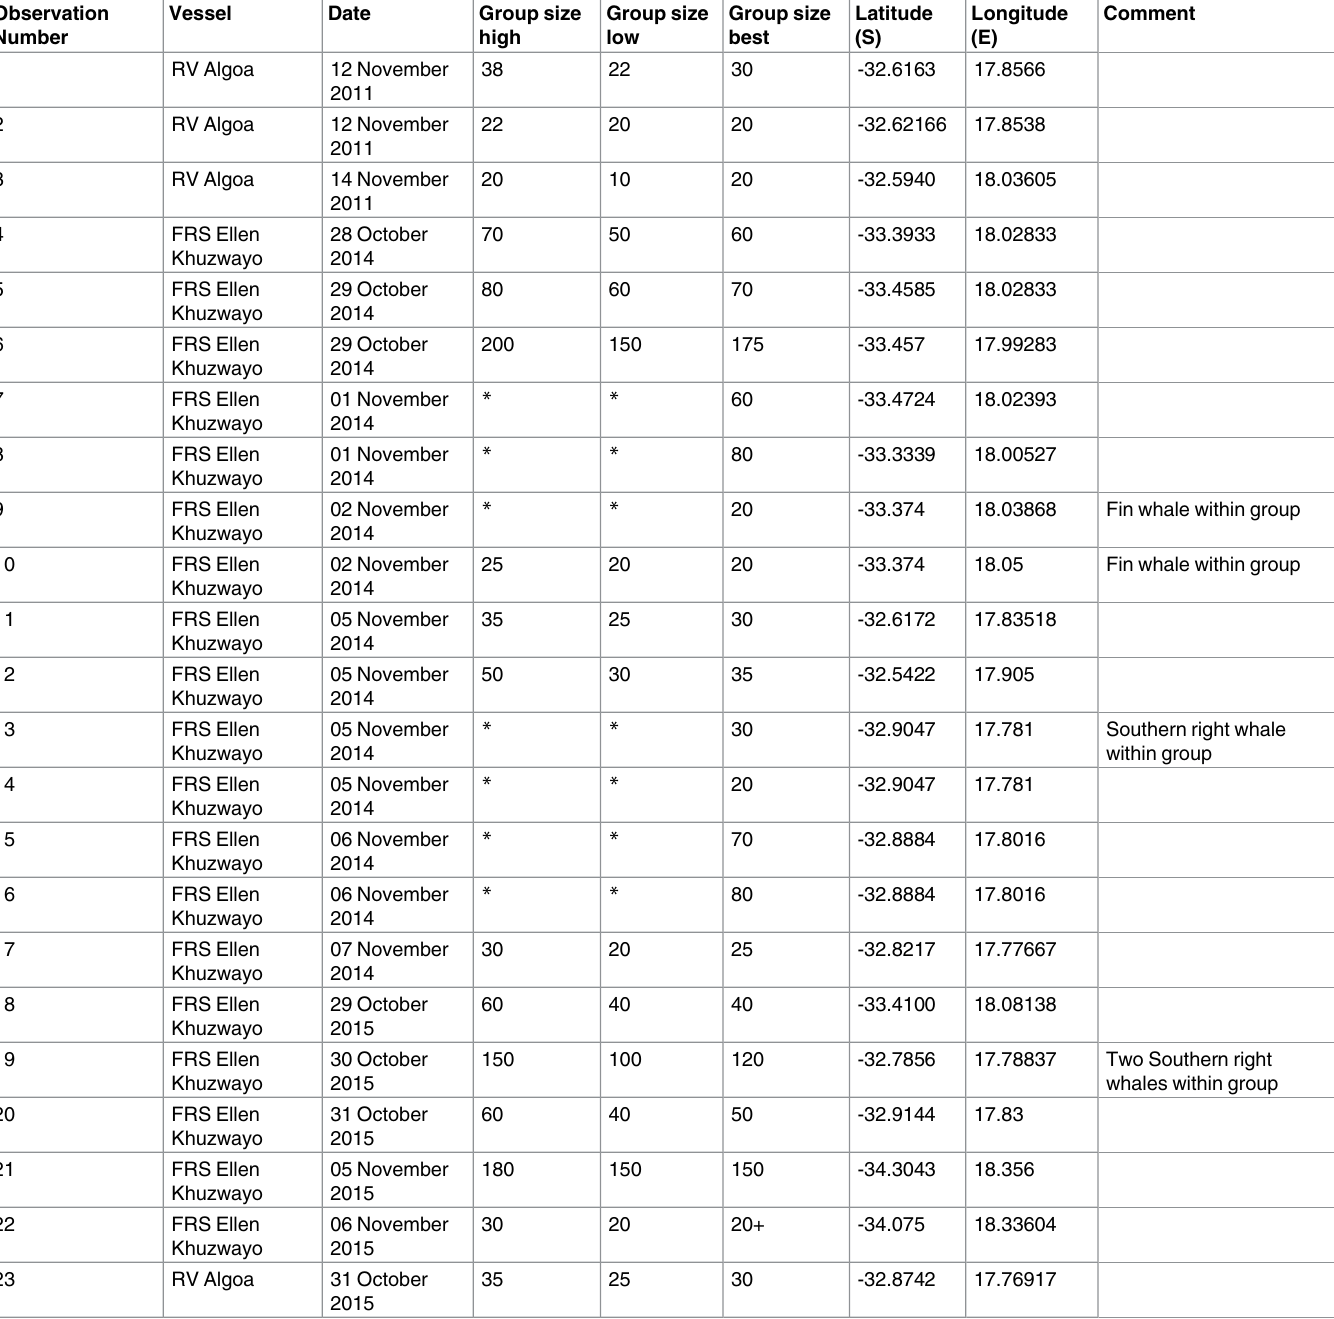
Table 1. Dedicated observations of “super-groups” encountered on cruises in the southern Benguela in 2011, 2014 and 2015. Observation